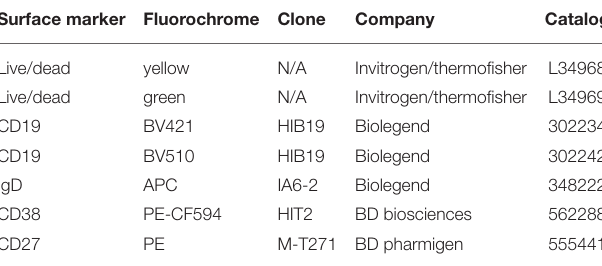
TABLE 1 | Antibodies used for surface staining and flow cytometry. Surface marker Fluorochrome